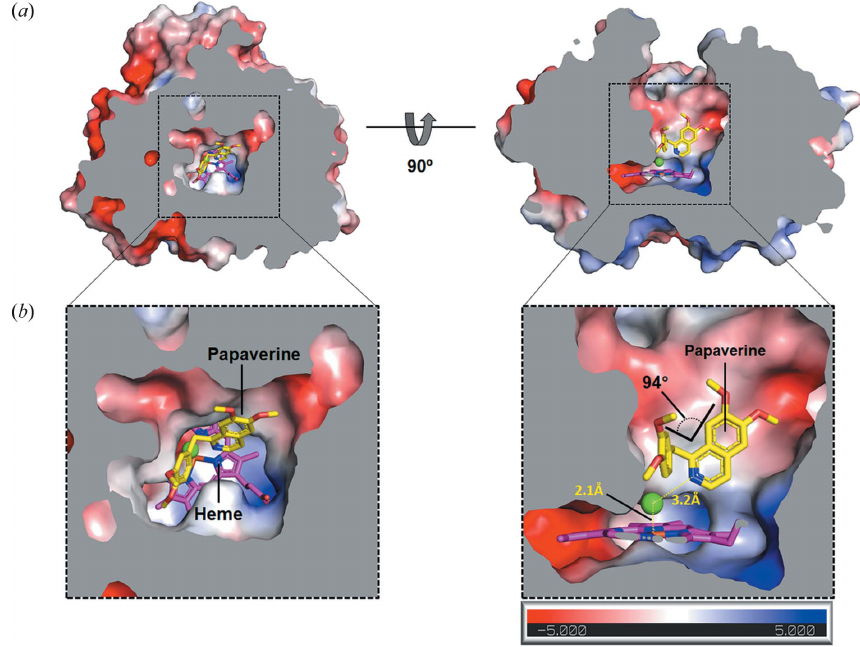
Figure 8 Bending motion of papaverine in the substrate-binding site of CYP105D18. ( a ) Detailed binding mode of papaverine with CYP105D18. Papaverine is at the bottom of the active site. The sphere of water molecules (green) is between the dimethodyisoquinoline nitrogen and iron of the heme group. Papaverine and heme are colored yellow and magenta, respectively. ( b ) Close-up view of the binding pocket in ( a ). Cross-sectional images of CYP105D18 were generated using PyMol (Schro¨dinger).